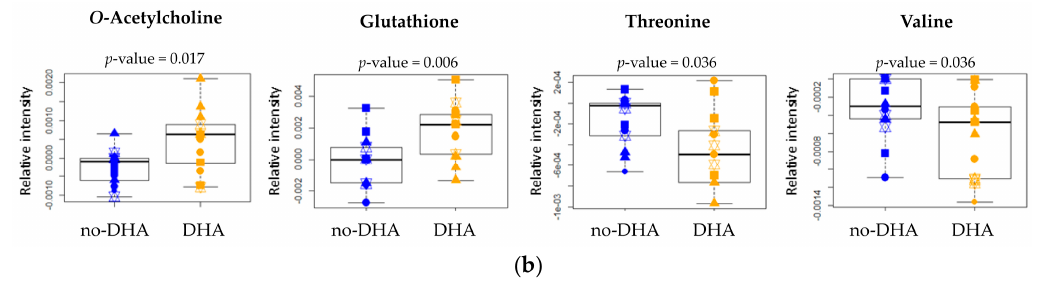
Figure 6. Box plots of the metabolites differentially concentrated in “no-DHA” (not supplemented (NS), protocatechuic acid (PCA), propionic acid (PRO), blue symbols) and “DHA” group (docosahexaenoic acid (DHA), DHA + PCA, DHA + PRO, yellow symbols) according to NMR analysis after ( a ) 6 h and ( b ) 24 h supplementation. For each comparison, the p -value (by the Wilcoxon test) is also reported.